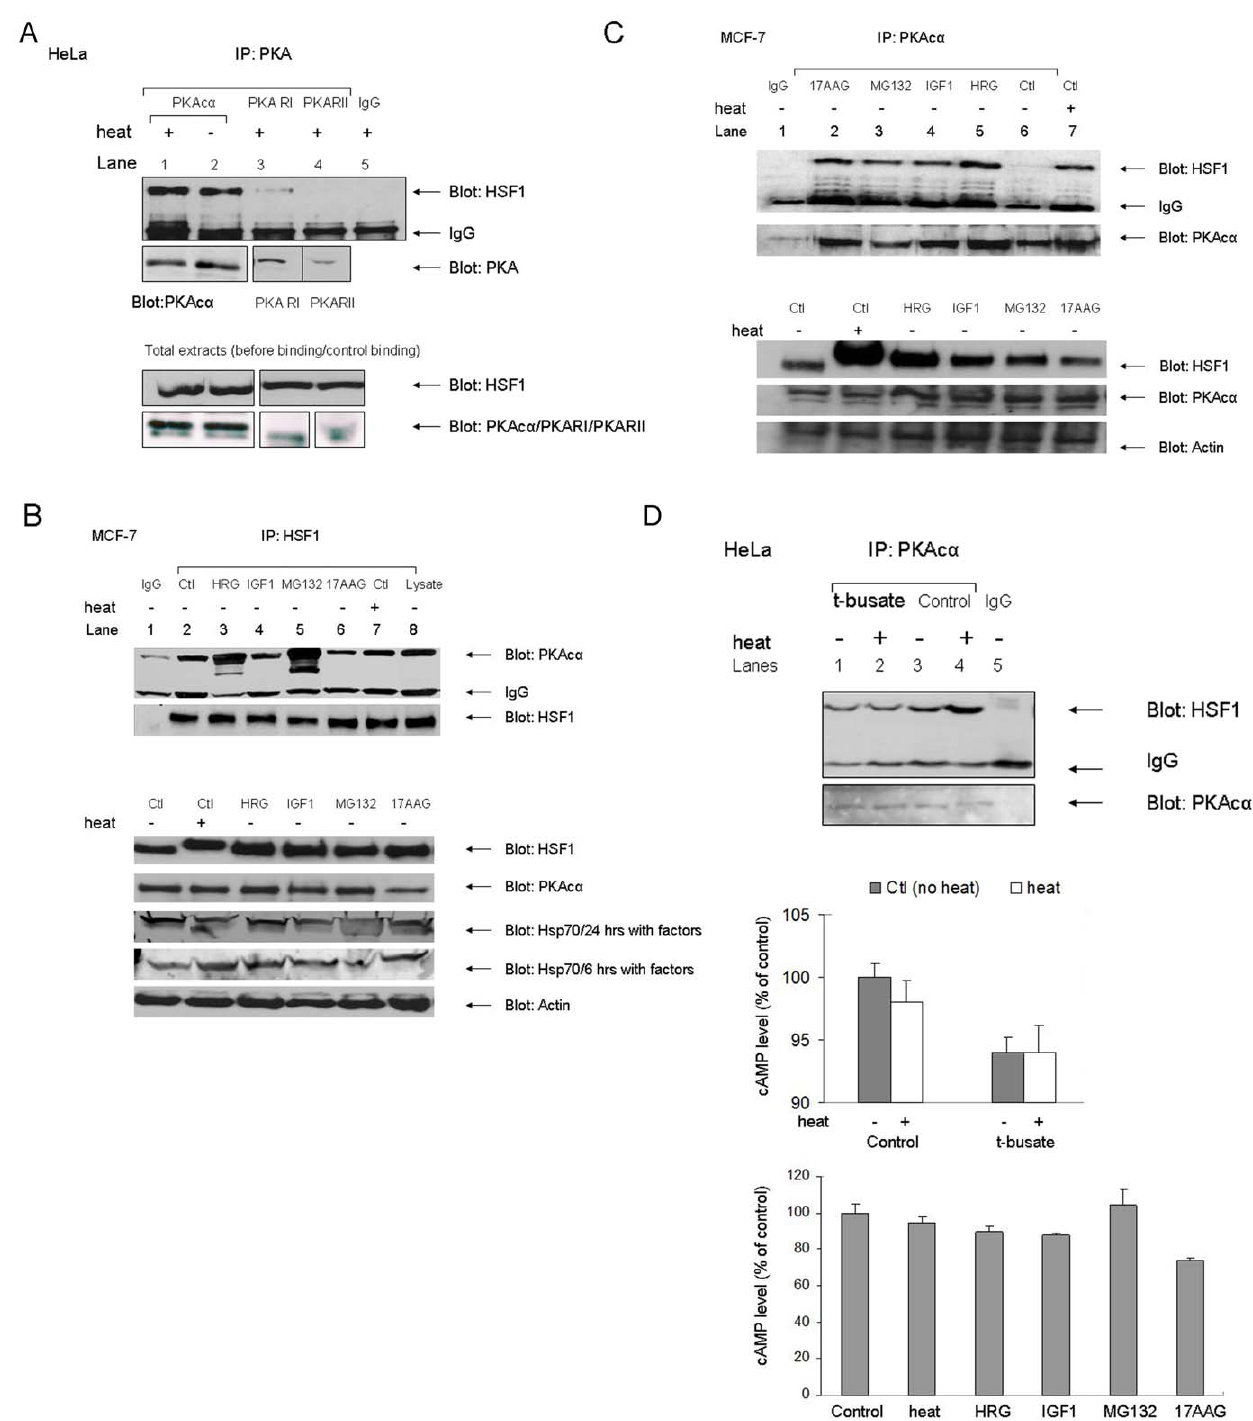
Figure 1. HSF1 binds to PKAc a in cells. A) Immunoprecipitation assays. HeLa cells were incubated for 1 hour at 37 u C or 43 u C before they were harvested on ice and equalized for protein concentration. Cell extracts were then probed by immunoprecipitation with either anti-PKAc a (lane 1,2) anti-PKARI (lane 3), anti-PKARII antibodies (lane 4) or rabbit IgG. Immunoprecipitates were then analyzed by 10% SDS-PAGE and immunoblot with anti-HSF1 antibodies. We have shown the IgG heavy chain to indicate the equal loading of immunoprecipitates in this experiment. The membrane was then stripped and re-probed sequentially with anti- PKAc a , PKARI and PKARII antibodies. We also analyzed the levels of HSF1, PKAc a , PKARI and PKARII in the cell lysate (prior to immunoprecipitation) and these data are shown beneath the immunoprecipitation data. Experiments were carried out in duplicate with similar findings. B) Immunoprecipitation assay with anti-HSF1 antibodies in MCF-7 cells. MCF-7 cells were incubated for 1 hour at 37 u C or 43 u C. Other cultures were simultaneously treated with growth factors (30 mM HRG or 100 ng/ml IGF-1 for 24 hr) or inhibitors (2 mM 17AAG for 24 hr, 5 m M MG-132 for 6 hr) as indicated on the figure (panels 3–6). Cell lysates were then prepared as in (A). Immunoprecipitation was performed with anti-HSF1 antibodies and immunoprecipitates later analyzed by immunoblot with anti- PKAc a antibodies. Equal amounts of immunoprecipitated proteins were loaded and immunoblotted with anti-HSF1 and anti- PKAc a antibodies. Again, we have shown the IgG heavy